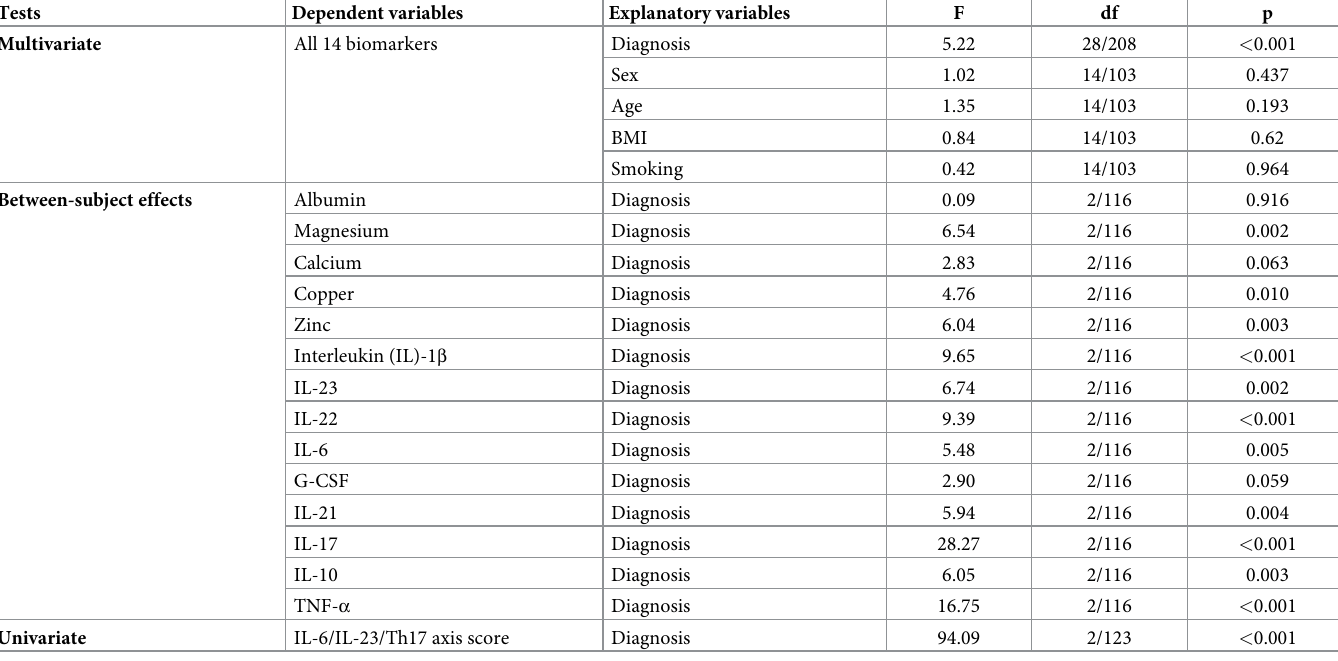
The results of these GLM analyses were adjusted for use of olanzapine, clozapine, modecate, kemadrine, risperidone, benzodiazepines, mood stabilizers (not shown as all